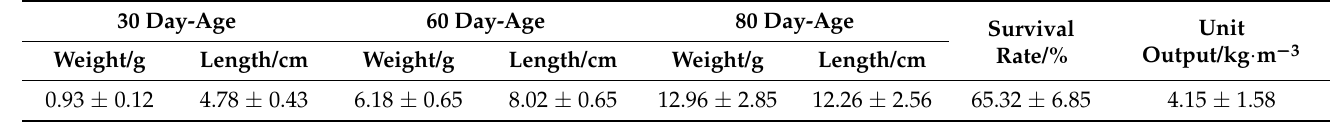
Table 3. Prawn growth and culture effect of large-scale biofloc shrimp culture facility